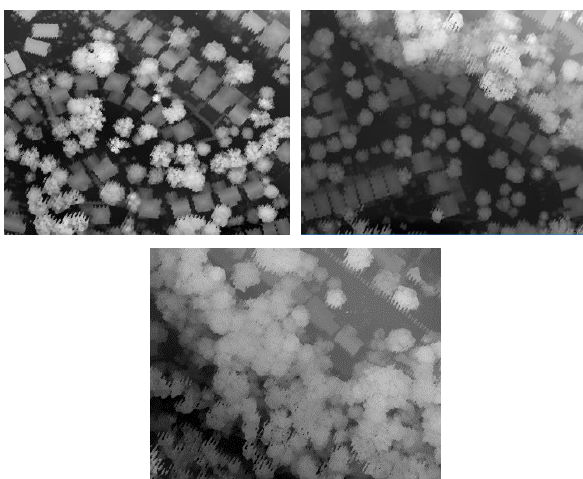
Figure 4. DSM - Zone 1 (Top Left - Urban with low relief), Zone 2 (Top Right – Urban and Forest scenes with high relief) and Zone 3 (Bottom – Forest scenes with high relief)